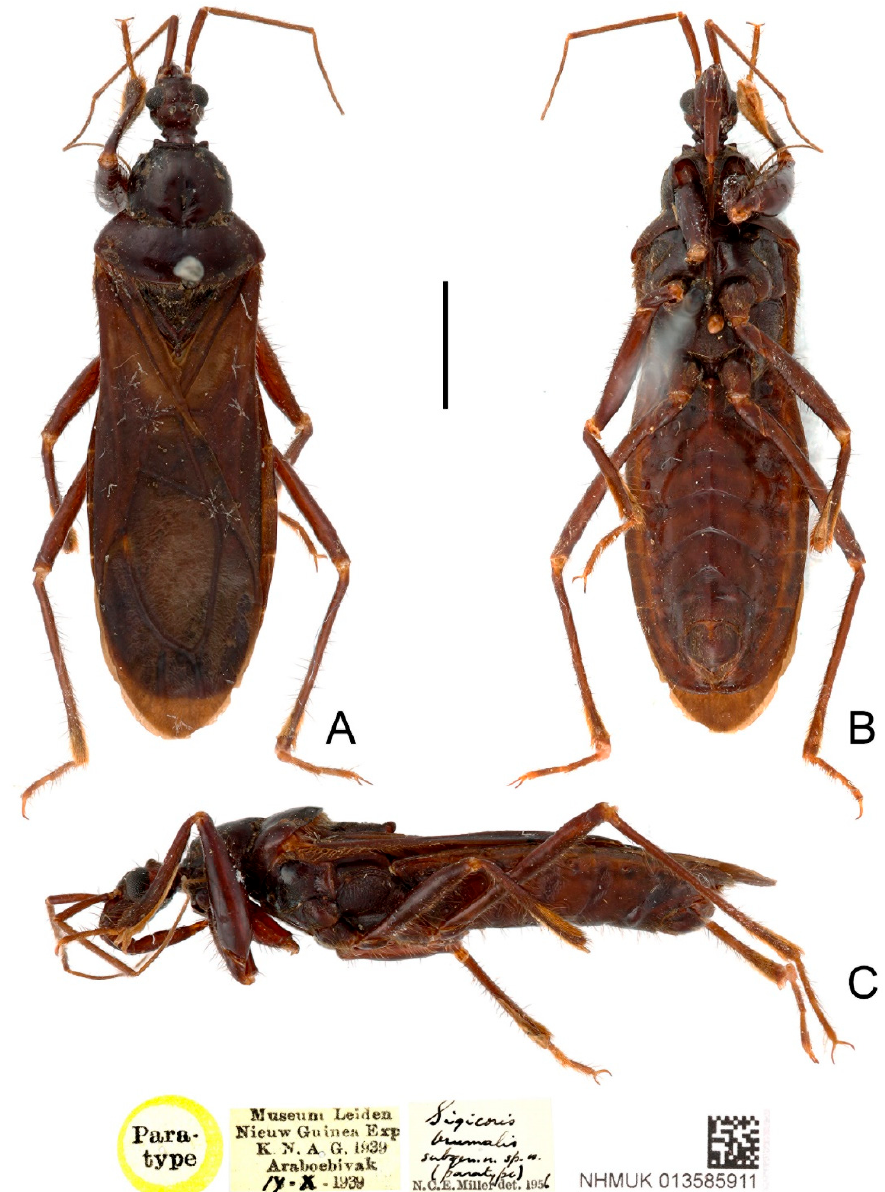
Figure 2. Sigicoris brumalis comb. nov. , paratype male, habitus. ( A ) Dorsal view. ( B ) Ventral view. ( C ) Lateral view. Scale bar = 3.00 mm. Diagnosis: Body blackish brown in large part; width of interocellar space subequal to width of ocellus; first visible segment of rostrum longer than third segment; pronotum with anterior margin slightly concave, collar process prominent, lateral pronotal angle narrowly rounded; fore tibia with fossula spongiosa occupying 2/3 of tibial length, mid tibia with fossula spongiosa occupying half of tibial length; median pygophore process long, slender and straight, apex sharp, slightly oblique to left side in caudal view, base of inner margin serrated in lateral view; parameres subtriangular with inner margin concave; lower half of inner margin of lateral phallothecal sclerite with two processes, one upward and one